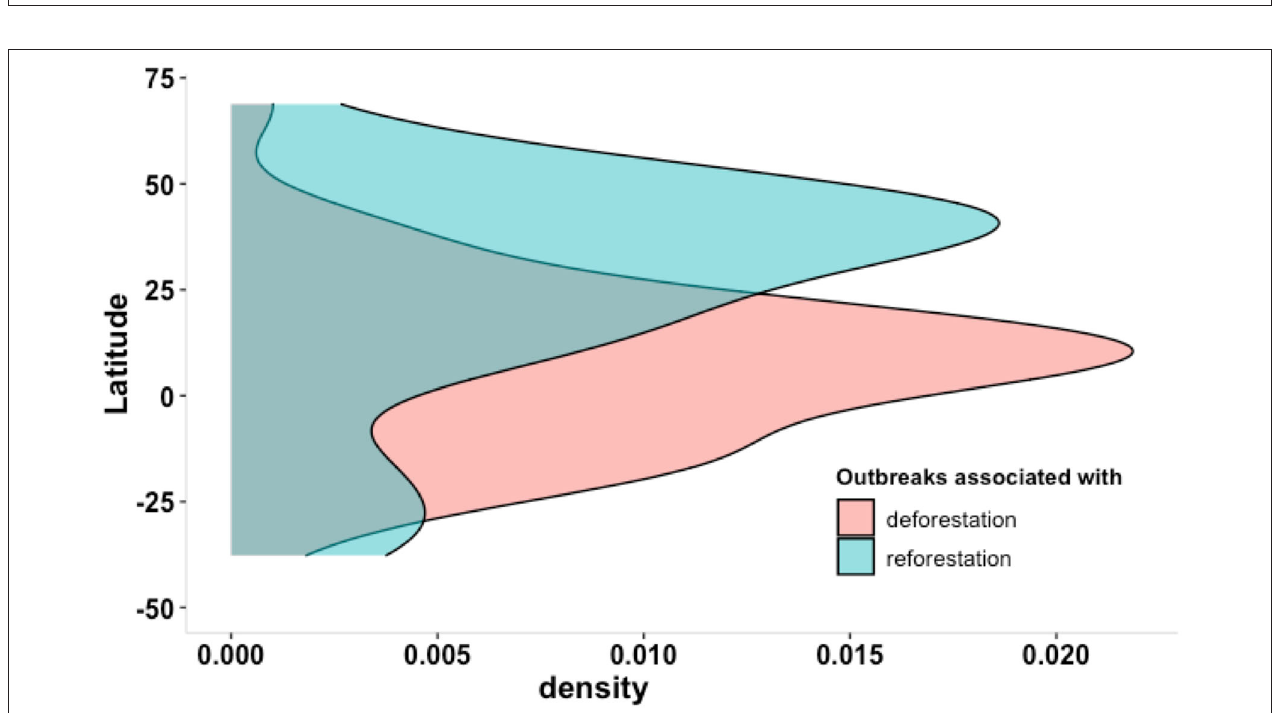
FIGURE 5 | Density plot of significant association between outbreaks of zoonotic and vector-borne diseases with deforestation (in red) or reforestation (in green) in relation to latitudinal gradient.